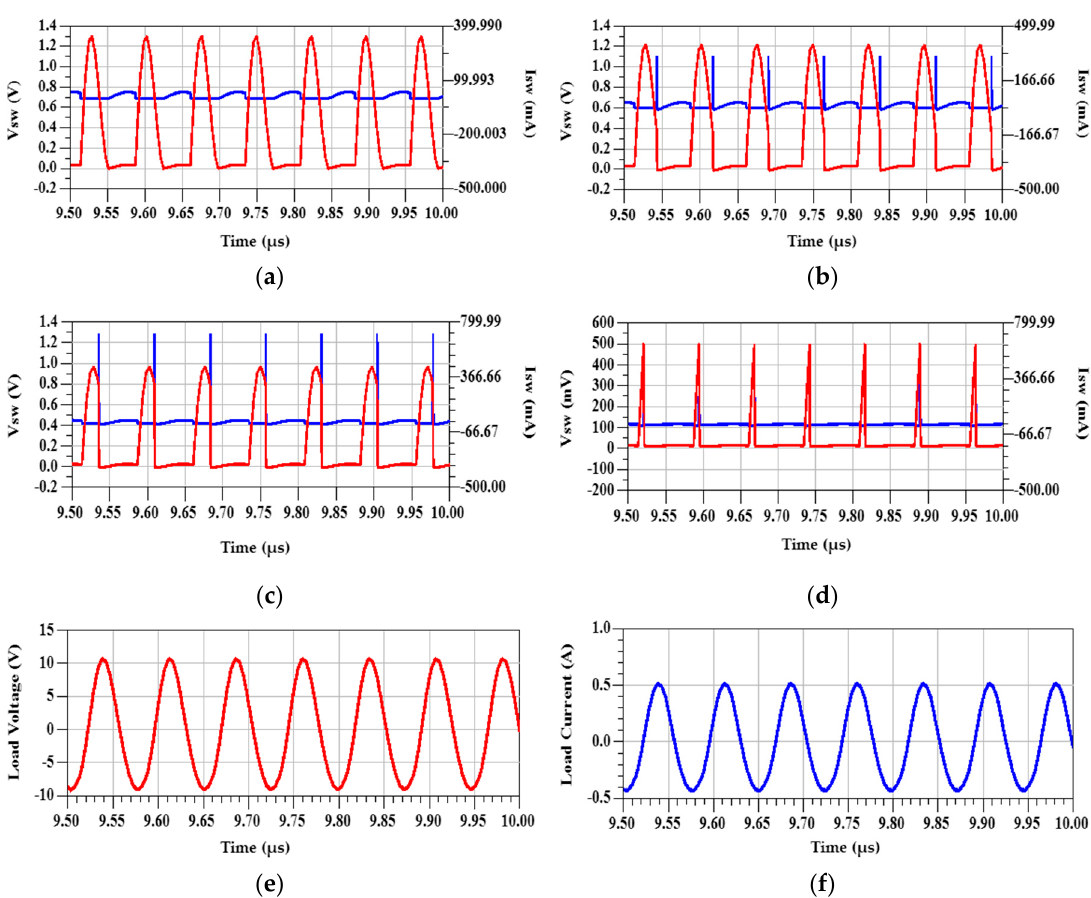
Figure 8. Switching voltage (red line) and current (blue line) of PA for different duty ratios: ( a ) δ = 0.45; ( b ) δ = 0.4; ( c ) δ = 0.3; ( d ) δ = 0.2; ( e ) load voltage at δ = 0.45; and ( f ) load current at δ = 0.45.